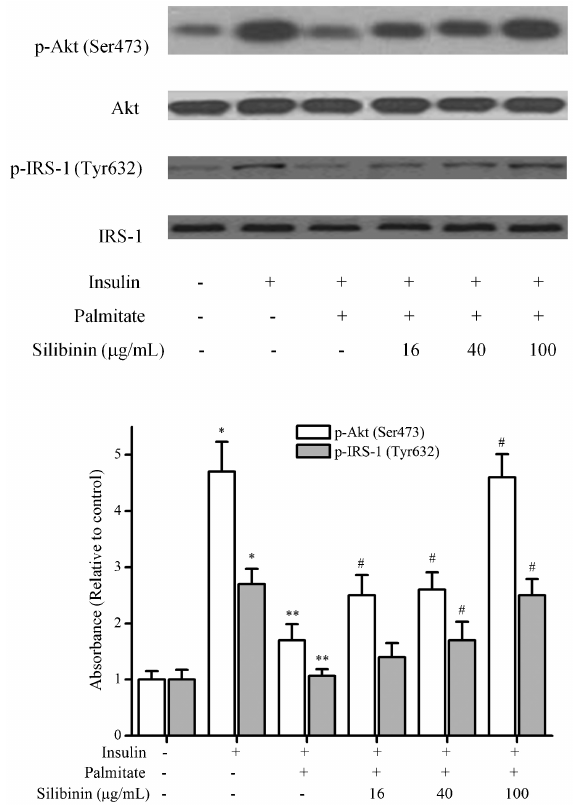
Figure 4. Effects of silibinin on the palmitate-inhibited insulin signaling pathway in C2C12 myotubes. C2C12 myotubes were incubated with palmitate (0.75 mM) or silibinin ++ palmitate as described in Methods. Before harvesting, the cells were incubated in the presence or absence of 100 nM insulin for 30 min and lysed for Western blotting. Data are reported as means±SD of 4 determinations. *P , 0.05, compared to control group; **P , 0.05, compared to insulin group; # P , 0.05, com- pared to palmitate group (Student’s t -test).